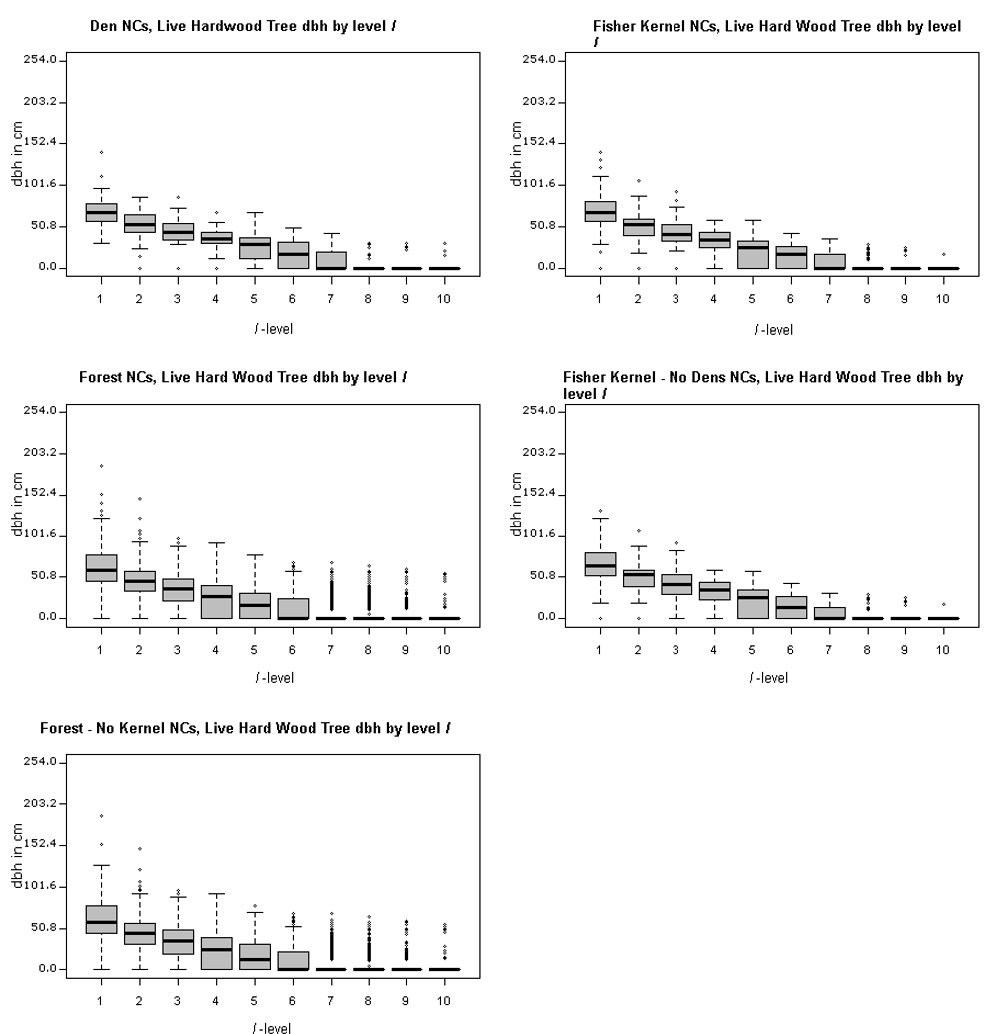
Figure 4. Largest dbh hardwood tree in plot level l for each NC distribution from left to right: Den, Kernel, Forest, Kernel excluding den NCs, and Forest excluding kernel NCs. Solid bar represents the median, gray box represents the 25% quartile above and below the mean, and the whiskers represent 3.5 times the upper and lower values of the gray box. The dots are individual values that lie outside the whiskers.